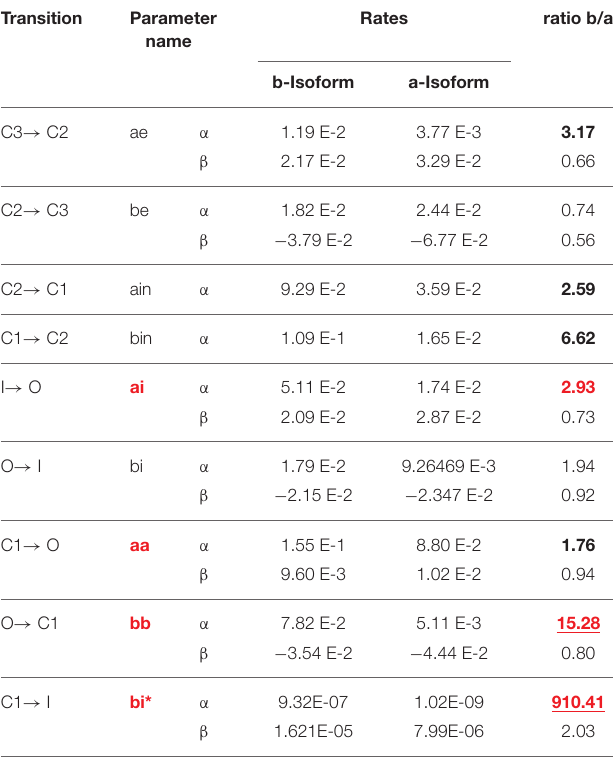
TABLE 2 | M-model 1 rate constants for transitions within hERG gating for a-isoform and b-isoform.